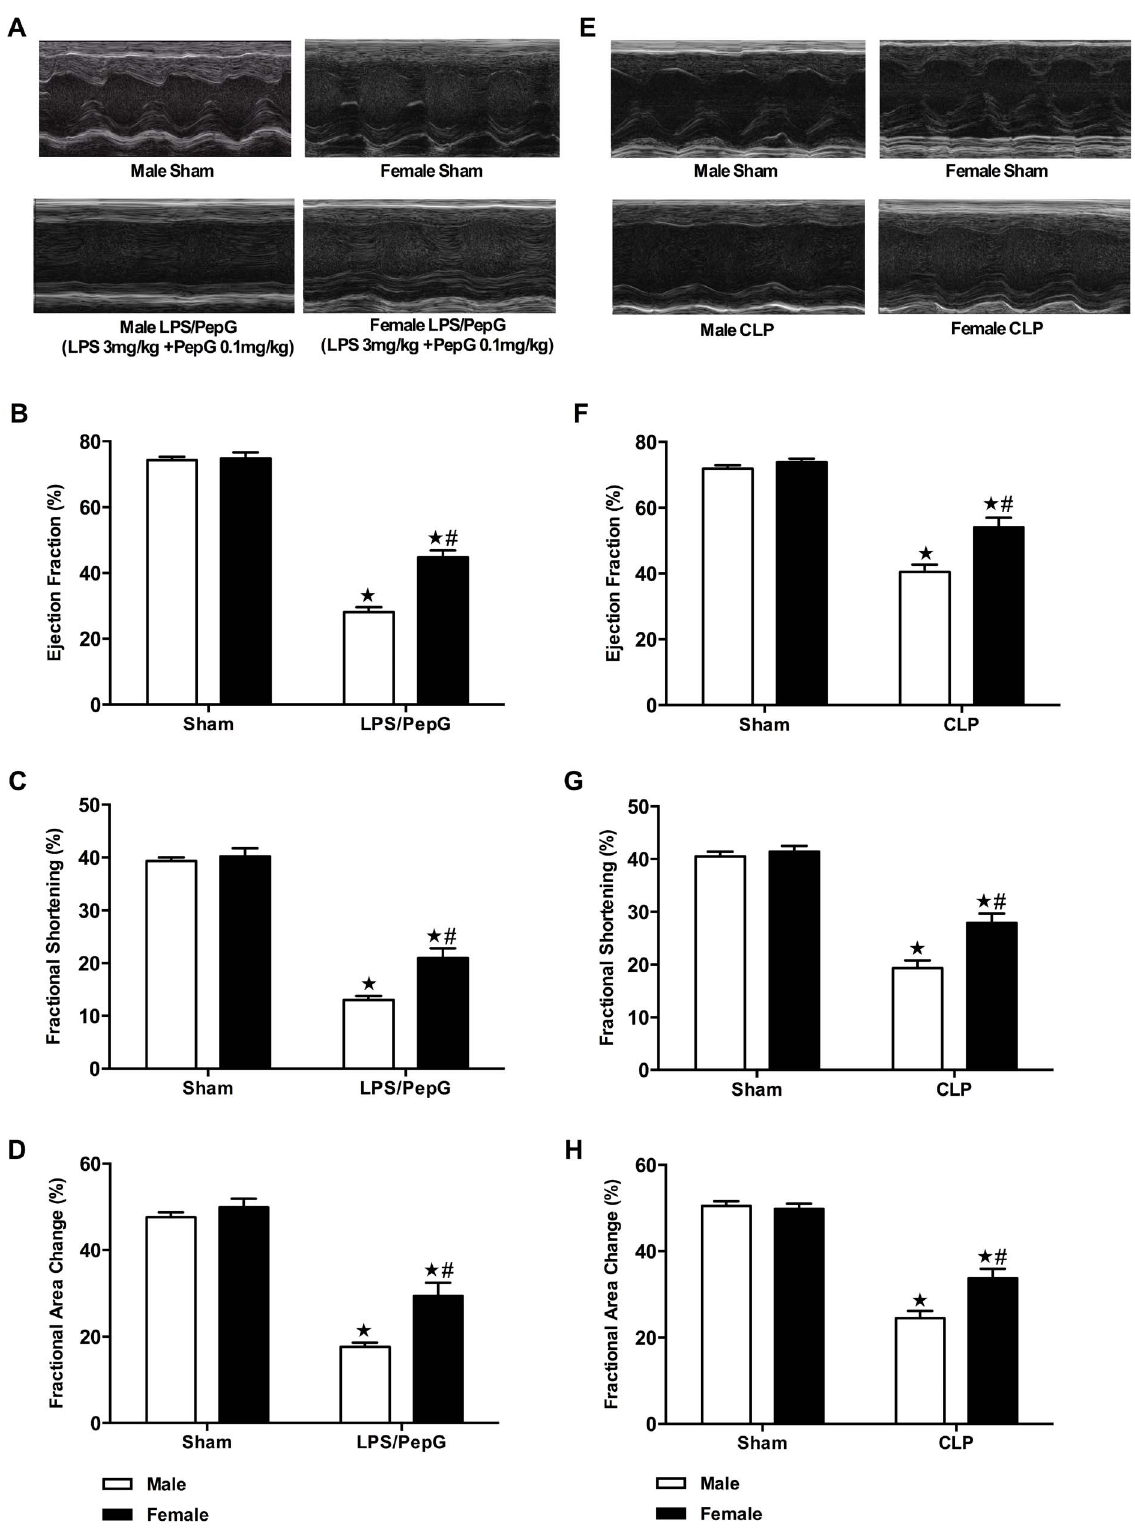
Figure 1. Gender dimorphism of cardiac dysfunction in mice subjected to LPS (3 mg/kg)/PepG (0.1 mg/kg) co-administration and in mice that underwent CLP. Panel A – D : Male or female mice received either LPS (3 mg/kg)/PepG (0.1 mg/kg) or PBS intraperitoneally. Cardiac function was assessed at 18 hours. ( A ) Representative M-mode echocardiograms; percentage (%) ( B ) ejection fraction (EF); ( C ) fractional shortening (FS); and ( D ) fractional area of change (FAC). The following groups were studied: Male + vehicle (n=6); Female + vehicle (n=4); Male + LPS/PepG (n=7); Female + LPS/PepG (n=8). Panel E – H: Male or female mice were subjected to CLP or sham-operation. Cardiac function was assessed at 24 hours. ( E ) Representative M-mode echocardiograms; % ( F ) EF; ( G ) FS; and ( H ) FAC. The following groups were studied: Male + sham-operation (n=4); Female +